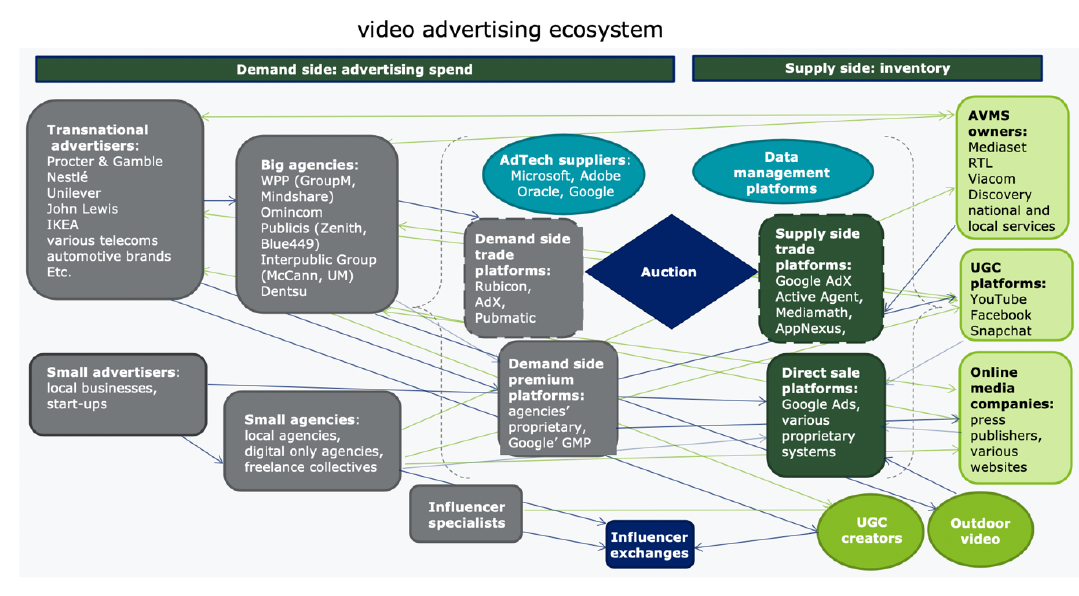
FIGURE 1: Integrated platform ecosystem for video advertising. Source: The authors, adapted and advanced from an earlier version in Broughton Micova & Jacques, 2019 p.